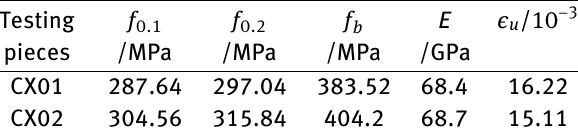
Table 1: Testing results of pieces standard material properties Testing